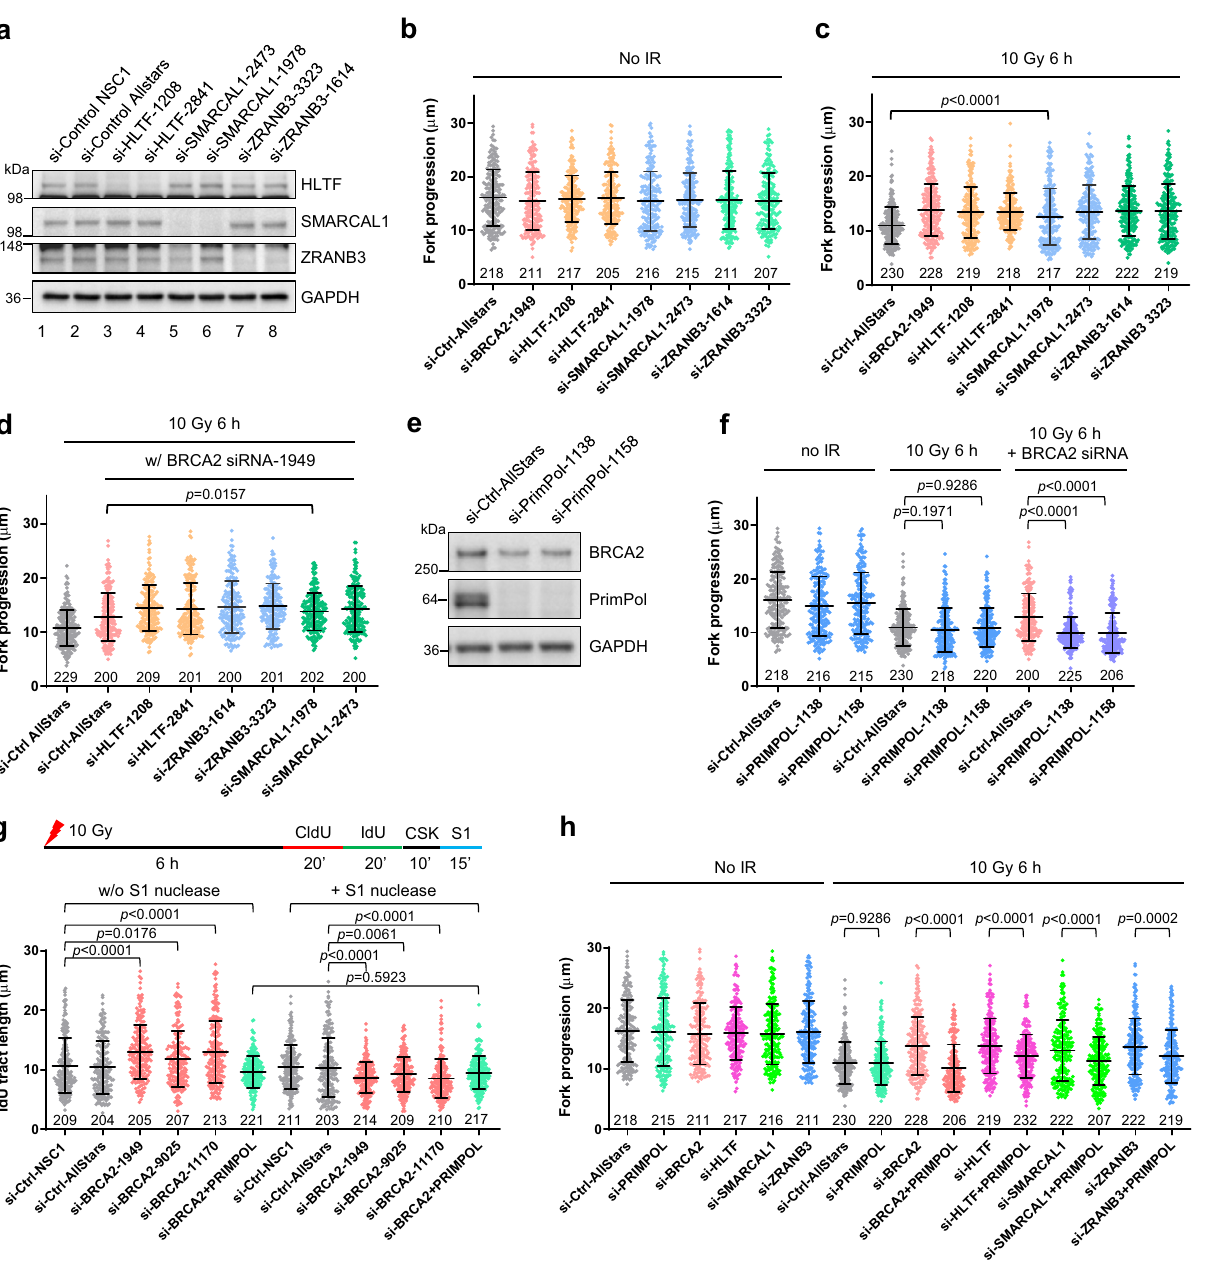
Fig. 2 BRCA2 suppresses PRIMPOL-mediated repriming and ssDNA gap formation after DNA damage. a Western blots showing siRNA-mediated depletion of HLTF, SMARCAL1, and ZRANB3 in U2OS cells. Two siRNAs for each gene were used. Similar results were obtained in n = 3 independent experiments. b , c Replication tract lengths in U2OS cells depleted of BRCA2, HLTF, SMARCAL1, or ZRANB3 either before ( b ) or 6 h after ( c ) 10 Gy of IR. d Replication tract lengths in U2OS cells co-depleted of BRCA2 with HLTF, SMARCAL1, or ZRANB3 at 6 h after 10 Gy of IR. e Western blots showing the levels of PRIMPOL depletion with two different siRNAs. Similar results were obtained in n = 3 independent experiments. f Replication tract lengths in U2OS cells depleted of PRIMPOL alone or co-depleted of PRIMPOL and BRCA2 before and 6 h after 10 Gy of IR. g Effect of S1 nuclease treatment on replication tract lengths in control and BRCA2-depleted U2OS cells at 6 h after 10 Gy of IR. h Replication tract lengths in U2OS cells depleted of BRCA2, HLTF, SMARCAL1, or ZRANB3 alone or in combination with PRIMPOL at 6 h after 10 Gy of IR. Data in ( b – d ) and ( f – h ) are presented as mean ± s.d., with the number of dots shown below each column. P values are calculated using two-tailed unpaired Student ’ s t test. Source data are provided as a Source Data fi